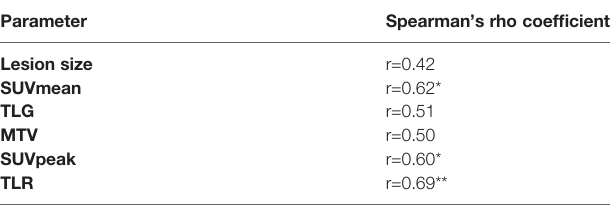
TABLE 4 | The correlation between pretreatment 18 F-FDG PET/CT parameters and pathological treatment response. Parameter